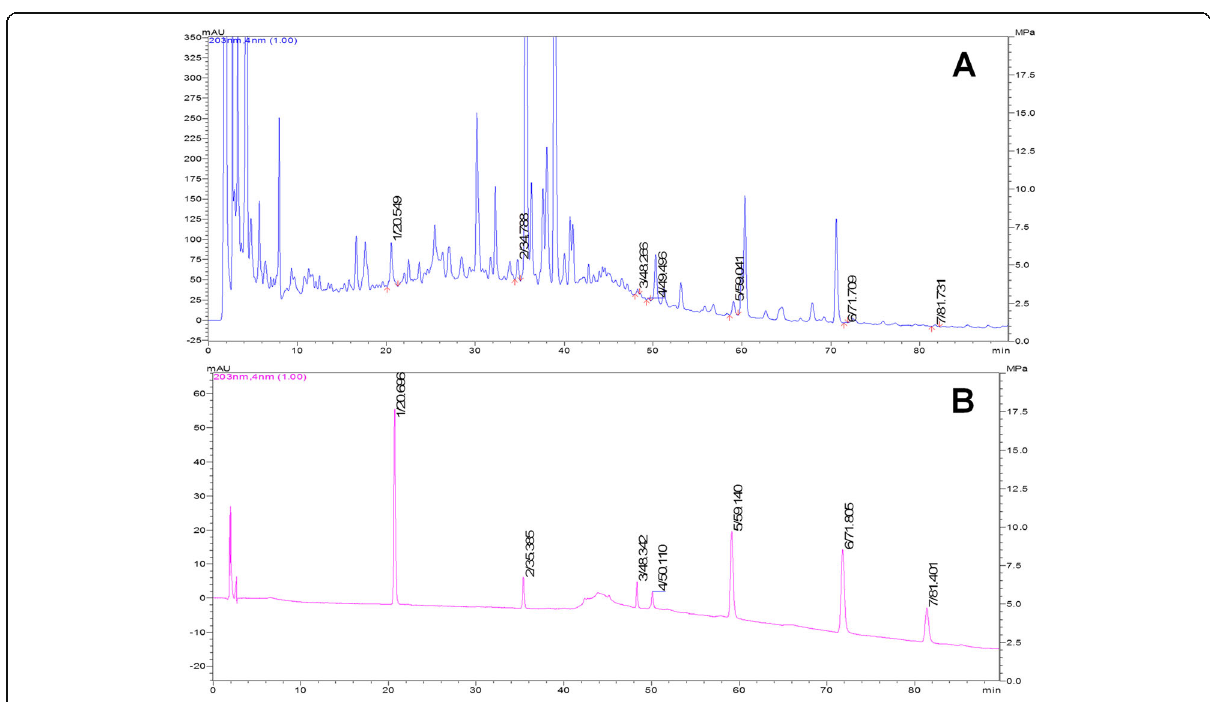
Fig. 1 HPLC chromatogram of WPX test sample ( a ) and reference sample ( b ). Notes: Peak: 1, Calycosin-7-glucoside; 2, ginsenoside-Rg1; 3, ginsenoside-Rb1; 4, astragaloside IV; 5 – 7, atractylenolide III, II, and I, respectively